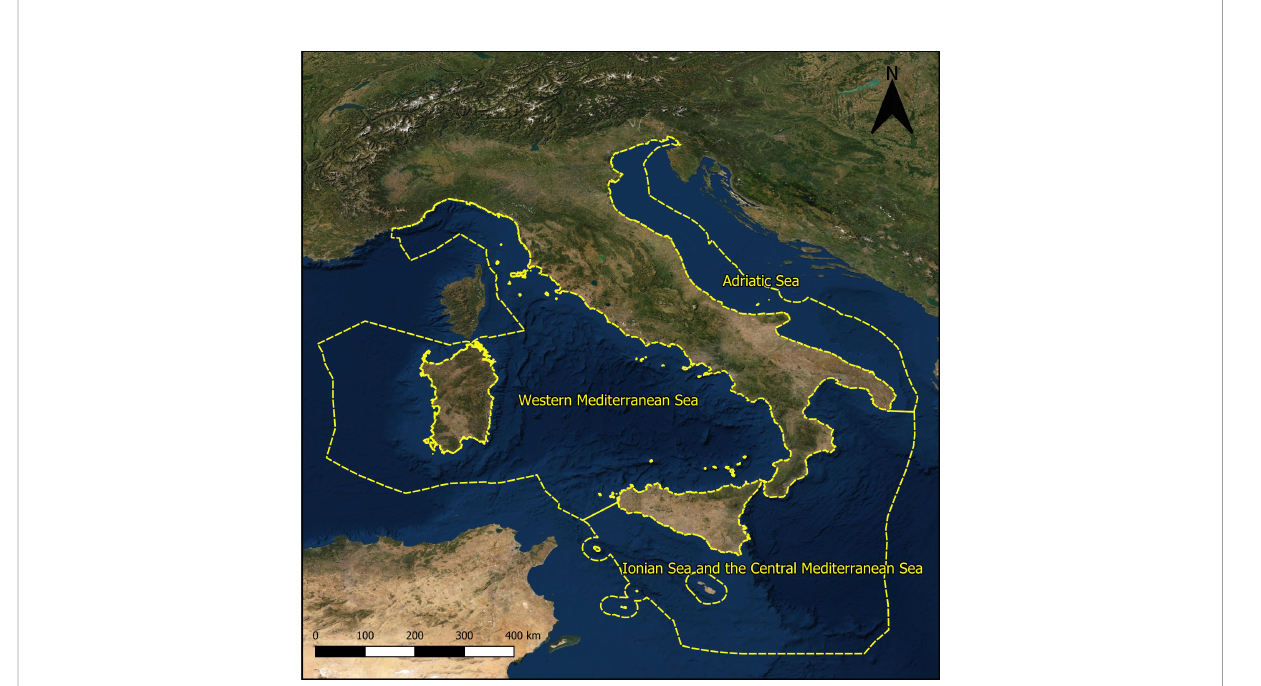
FIGURE 1 Italian subregions according to Marine Strategy Framework Directive